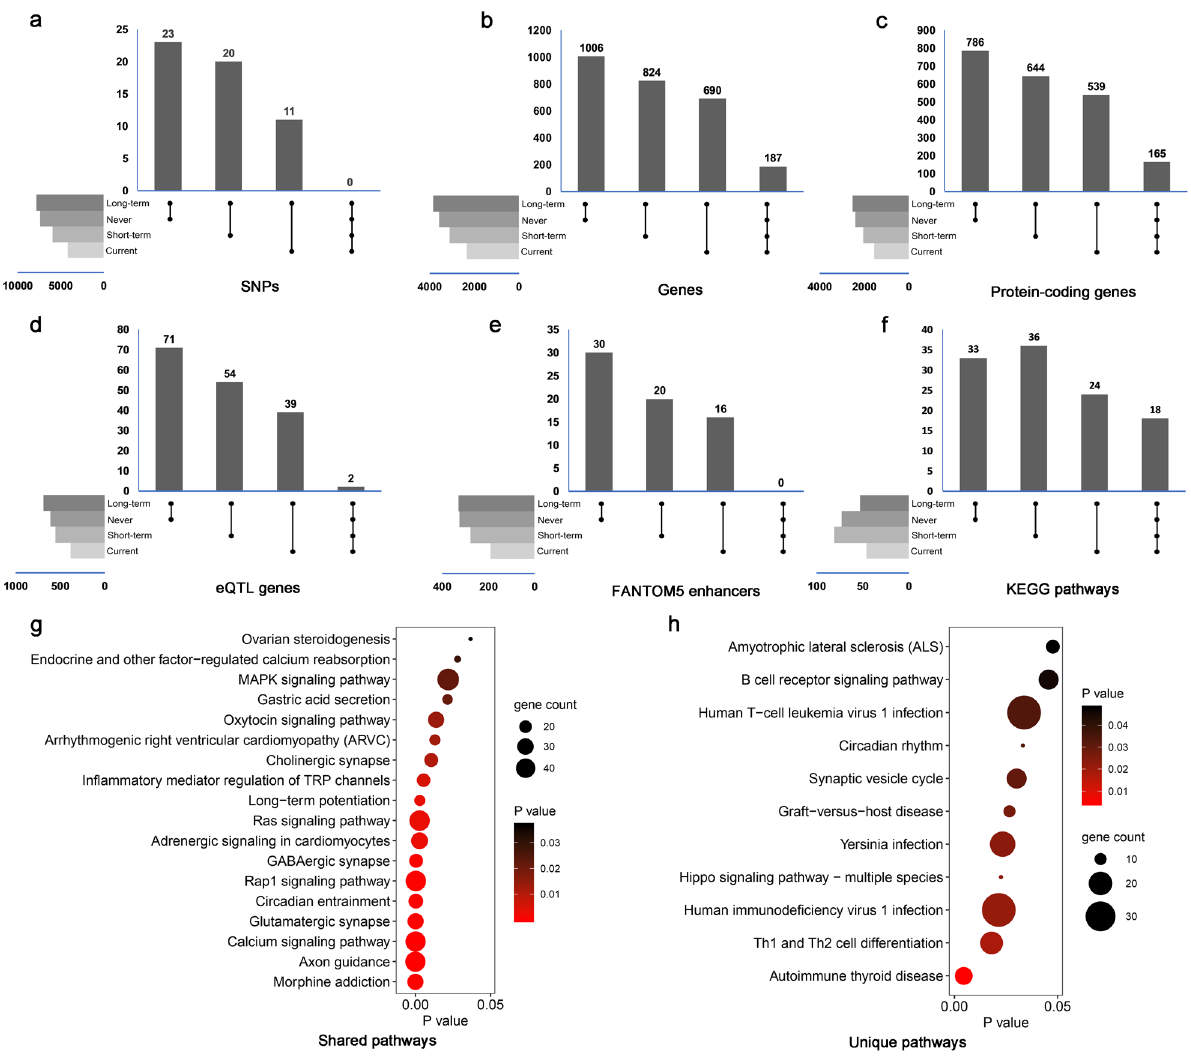
Fig. 4 Results of genetic similarity comparative analysis. Similarity comparison of SNPs with P < 10 − 3 at SNP level ( a ), germline-regulated gene level ( b ), germline-regulated protein-coding gene level ( c ), eQTL-related gene level ( d ), enhancer level ( e ), and KEGG pathway level ( f ), respectively. Protein-coding genes were de fi ned by the GENCODE database. g – h Shared and unique KEGG pathways in long-term former smokers compared with never, short-term former, and current